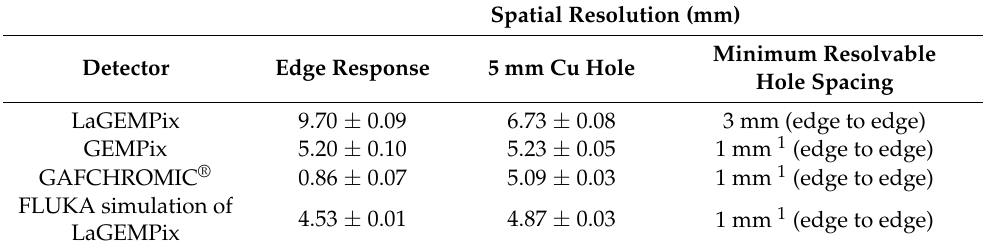
Table 3. Summary of the spatial resolution obtained for different experimental configurations and by different detectors. Results from the FLUKA Monte Carlo simulation are also included for